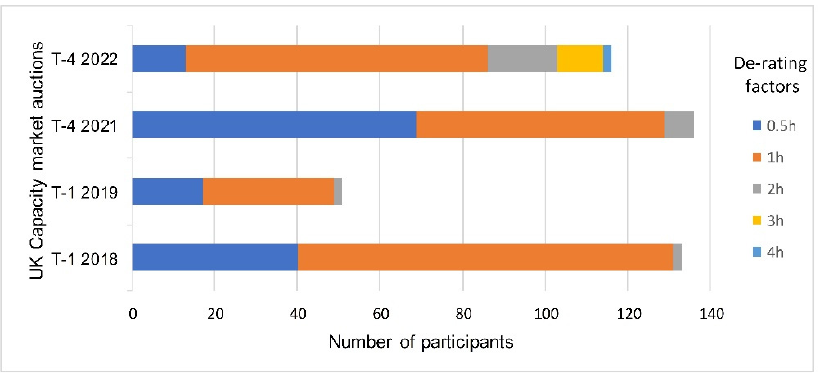
Figure 2. De-rated batteries in the UK capacity market for the period ranging from 2018 to 2022 [55].